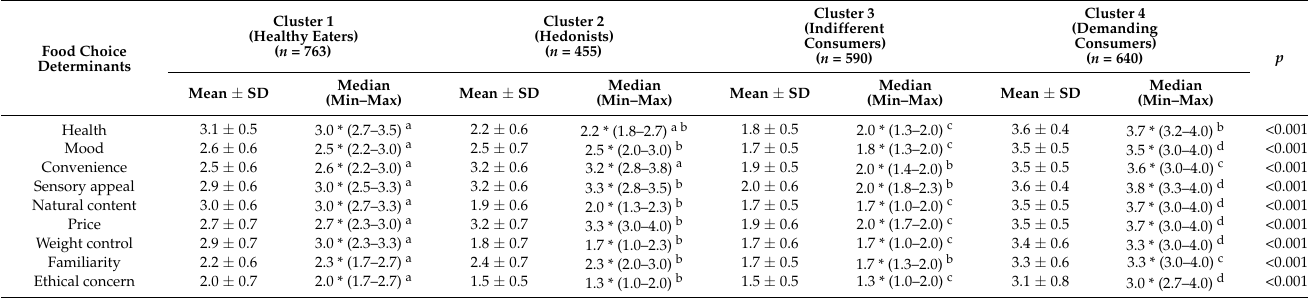
Table 1. The food choice determinants for subgroups were stratified based on the clustering of the scores assessed while using the Food Choice Questionnaire (FCQ) within the population of the second phase of the Polish Adolescents’ COVID-19 Experience (PLACE-19) Study ( n = 2448).